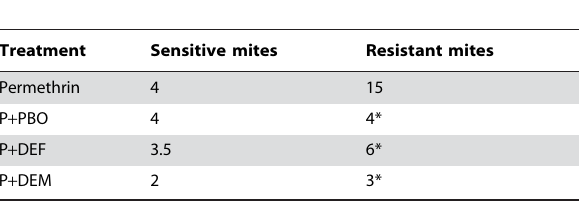
Table 1. Median survival (hrs) of sensitive and resistant mites in permethrin with and without